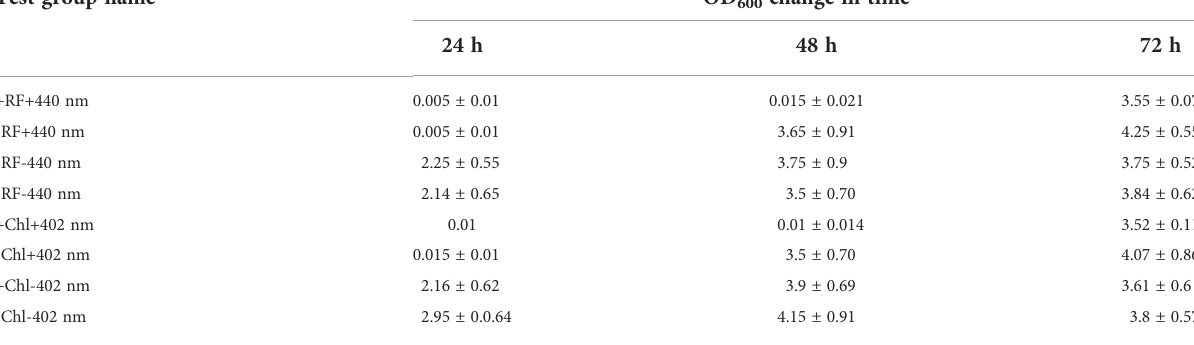
TABLE 5 Ability of the bio fi lm-forming Brevundimonas sp. ESA1 cells to regrow in LB media after short-term RF- and Chl-API (+RF+440 nm and +Chl+402 nm, respectively) using the irradiation box, irradiation without PSs (-RF+440 nm and -Chl+402